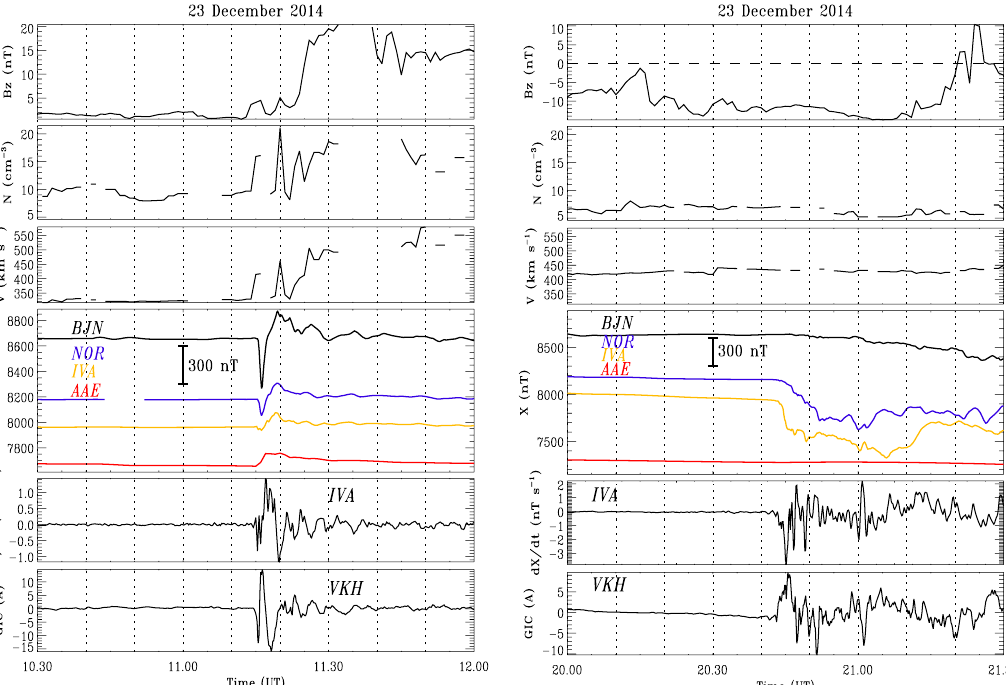
Fig. 2. The interplanetary shock and substorm impacts on geomagnetic fi elds and electrical power lines during 23 December 2014: SC (left panel) and substorm onset (right panel). The panels from top to the bottom are the solar wind density N and velocity V (1-min data from the OMNI database); magnetic records ( X -component) from the geomagnetic stations BJN, NOR, IVA (10-s data), and AAE (1-s data); time derivative of magnetic fi eld d X /d t [nT s (cid:1) 1 ] at the station IVA; and GIC [Amperes] at the station VKH (10-s